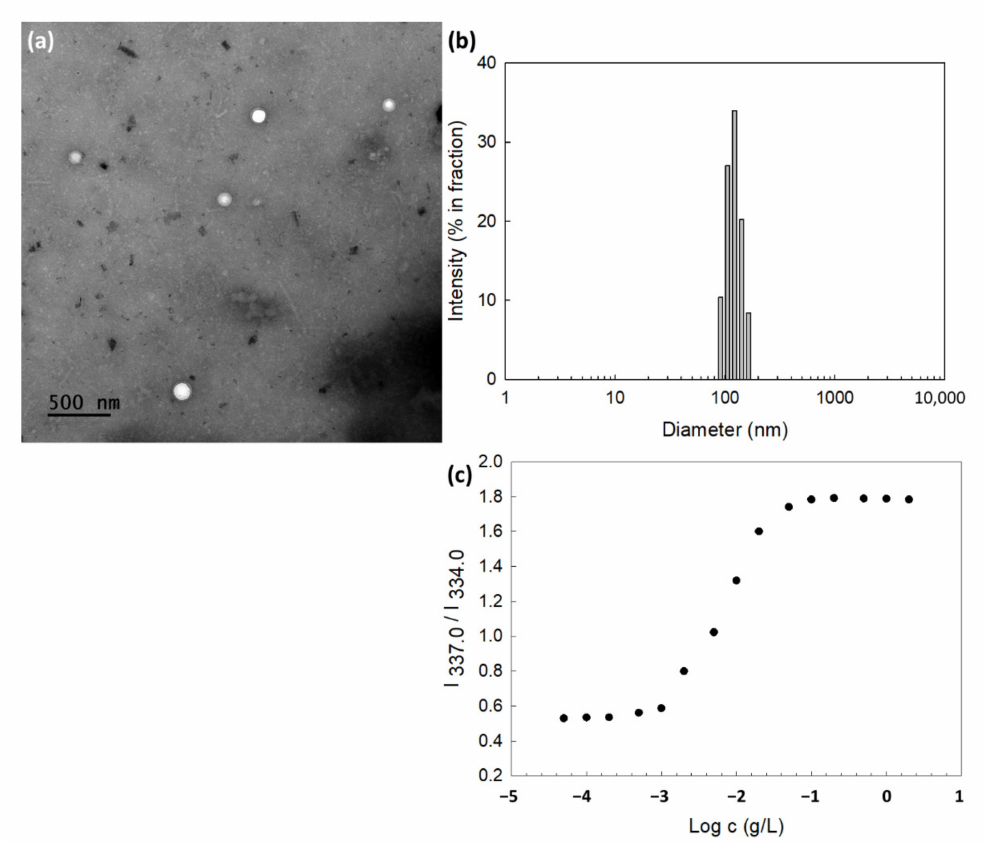
Figure 2. ( a ) Morphological observation and ( b ) typical particle size distribution of ChitoHISss